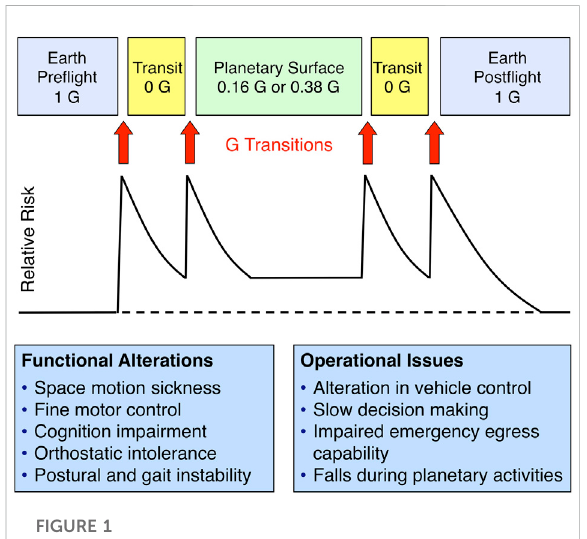
FIGURE 1 Performance decrements associated with sensorimotor disturbances occur during and after gravity (G) transitions. Photos credit NASA.